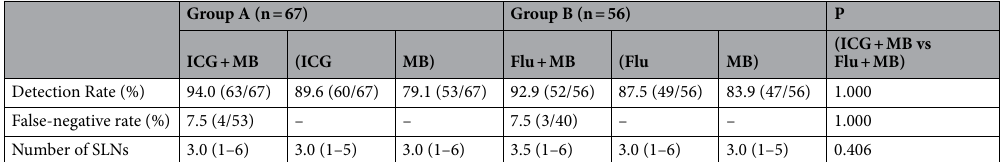
Table 2. Comparison of biopsy results between the two groups. ICG Indocyanine green, MB Methylene blue, Flu Fluorescein, SLNs sentinel lymph nodes.